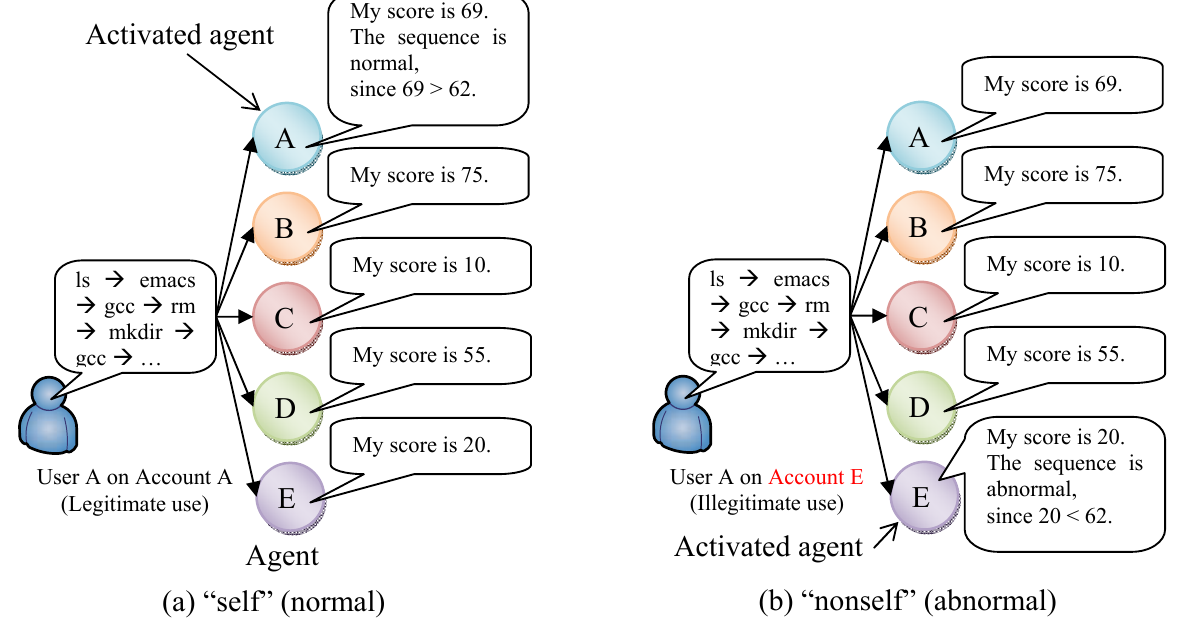
Figure 2. Discrimination of self (a) and nonself (b). There are five users on a computer. An agent is generated on every account. Let the threshold (cid:1846)(cid:1860) be 80%. When these